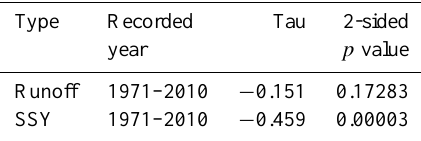
Table 3. Mann–Kendall trend tests of runoff and SSY in Kejie wa- tershed; Tau is the Mann–Kendall rank correlation